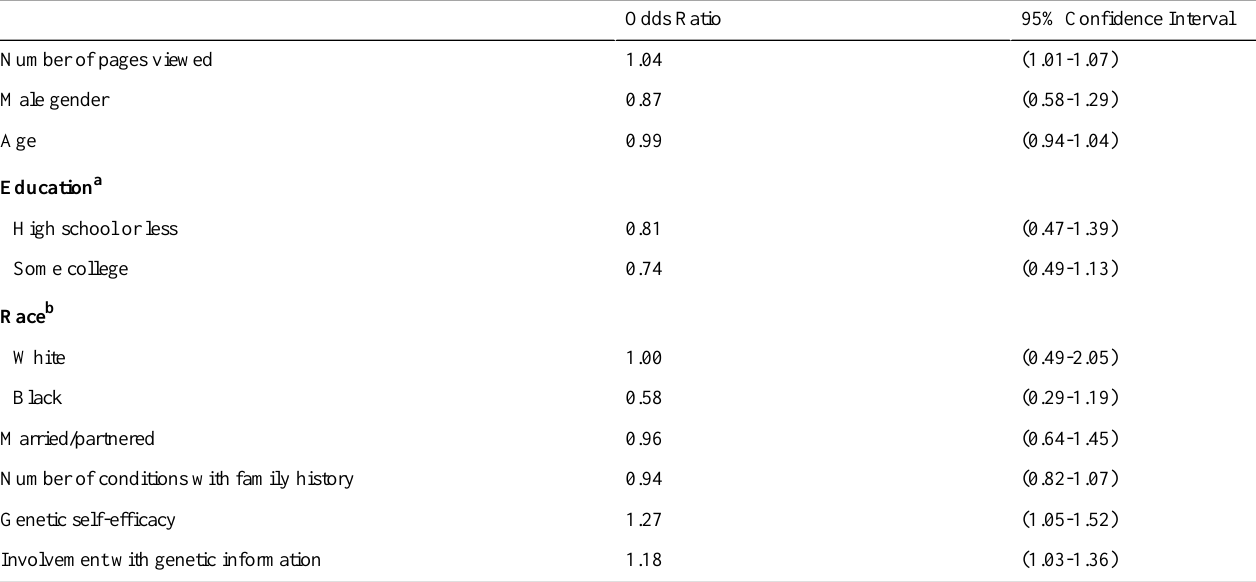
Table 2. Prediction of ease of decision making by number of pages viewed in a multivariate logistic regression model (n = 523)